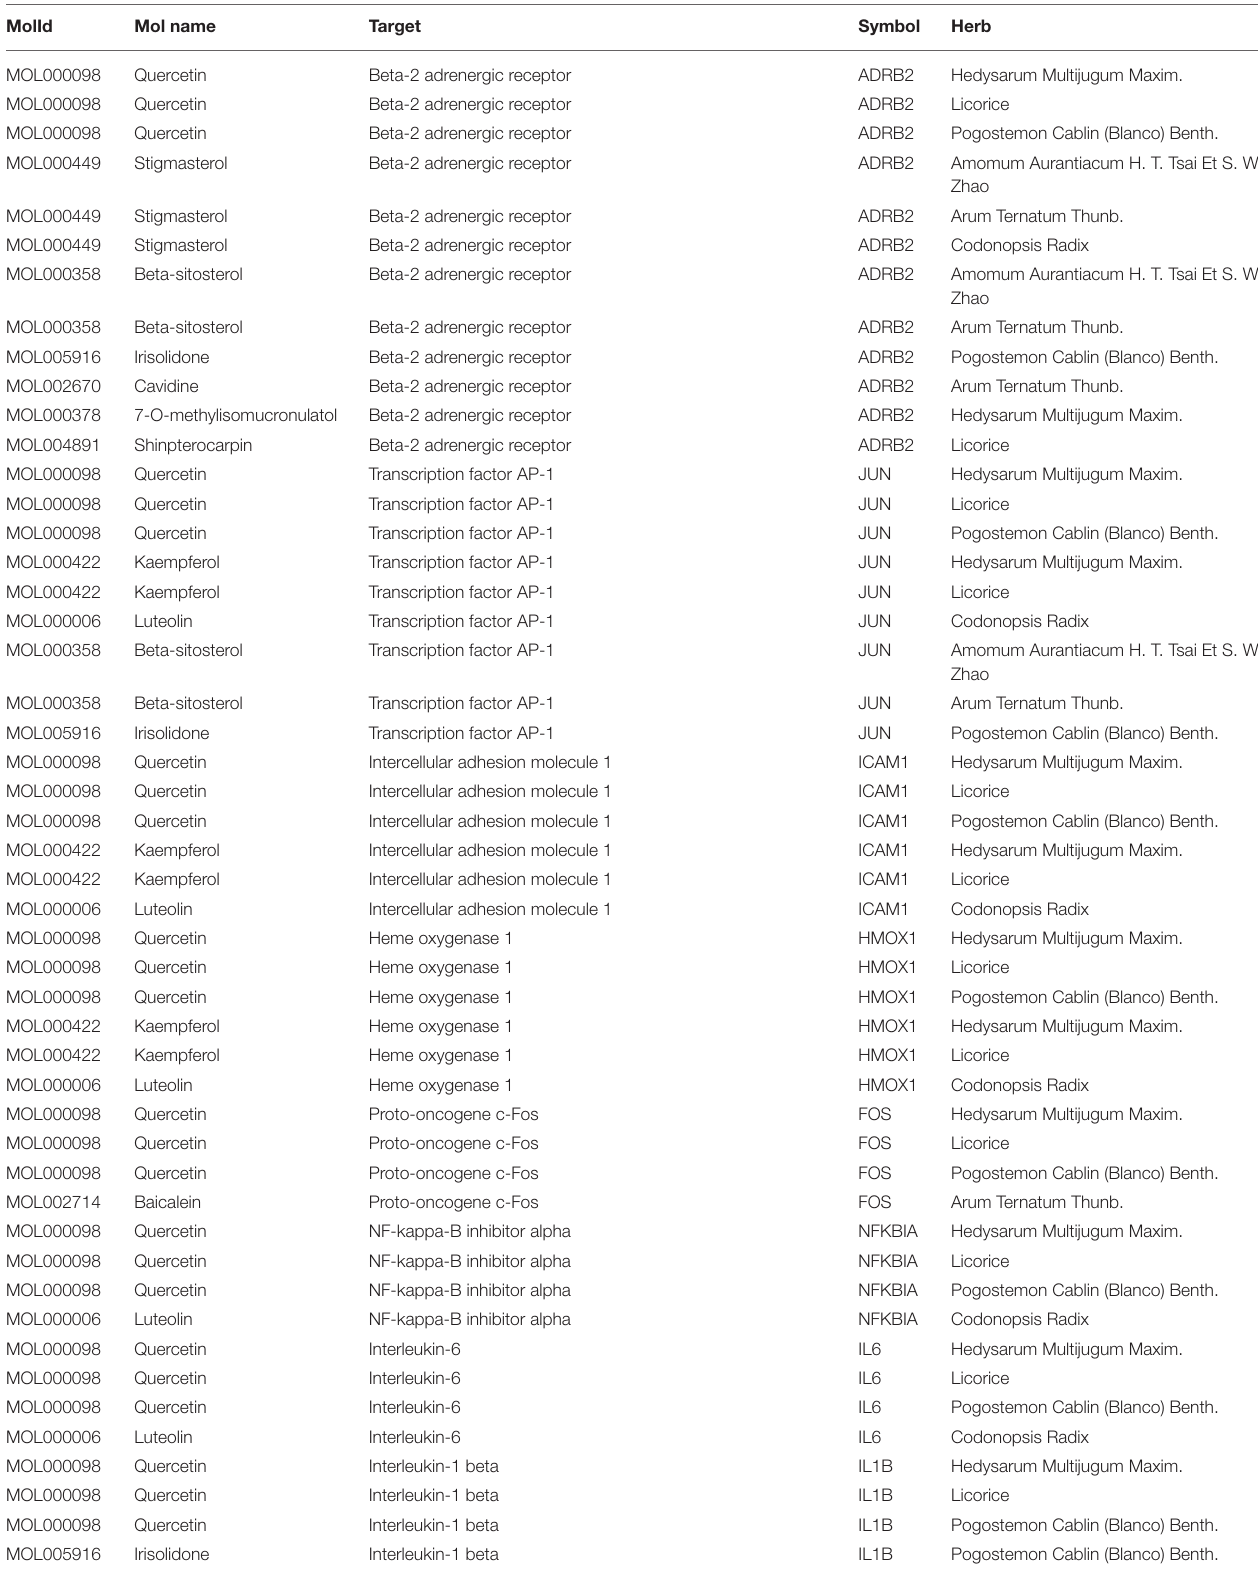
TABLE 3 | Predicted targets of the top 10 active ingredients, with their corresponding genes in FPQXZ.